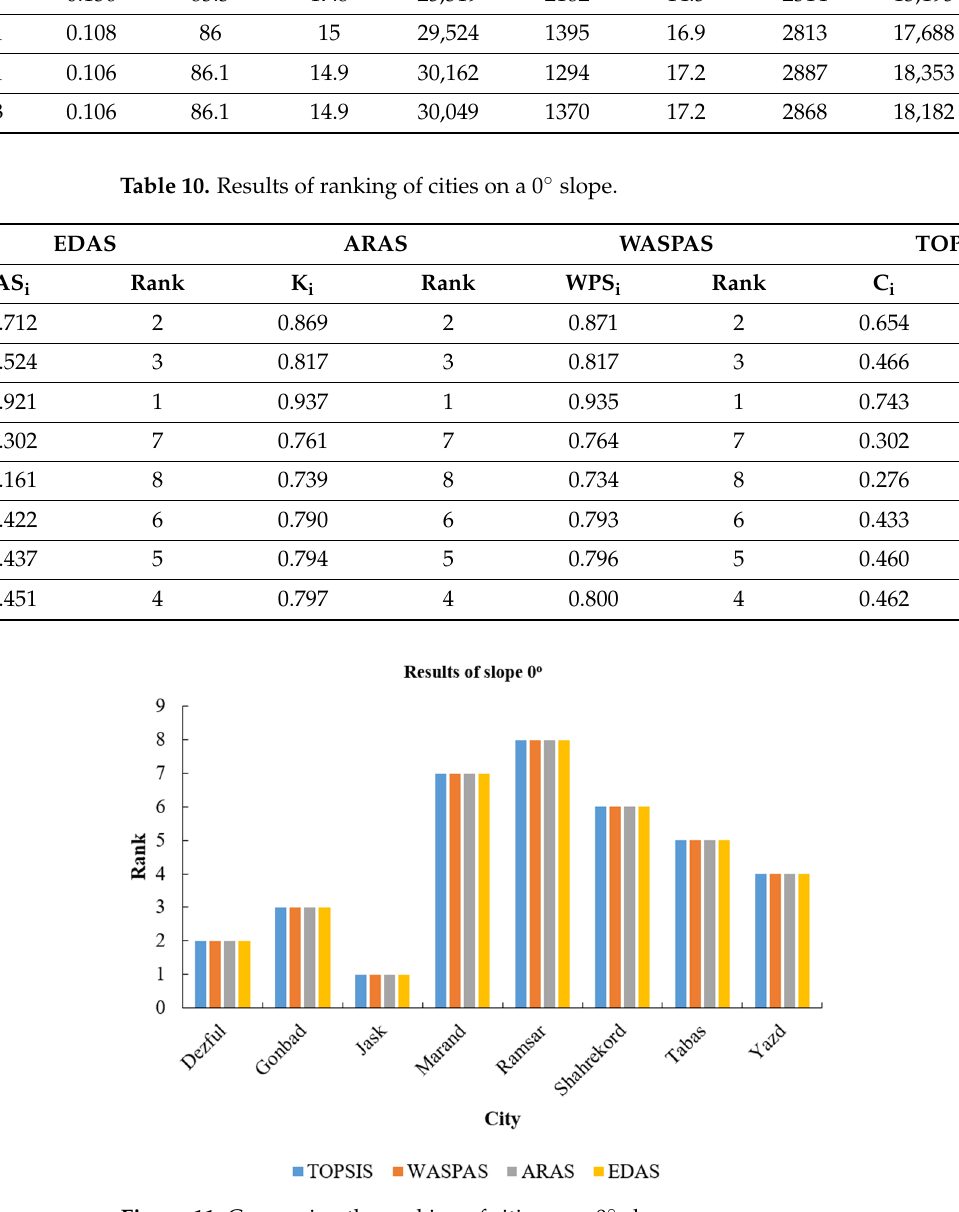
Table 10. Results of ranking of cities on a 0° slope.